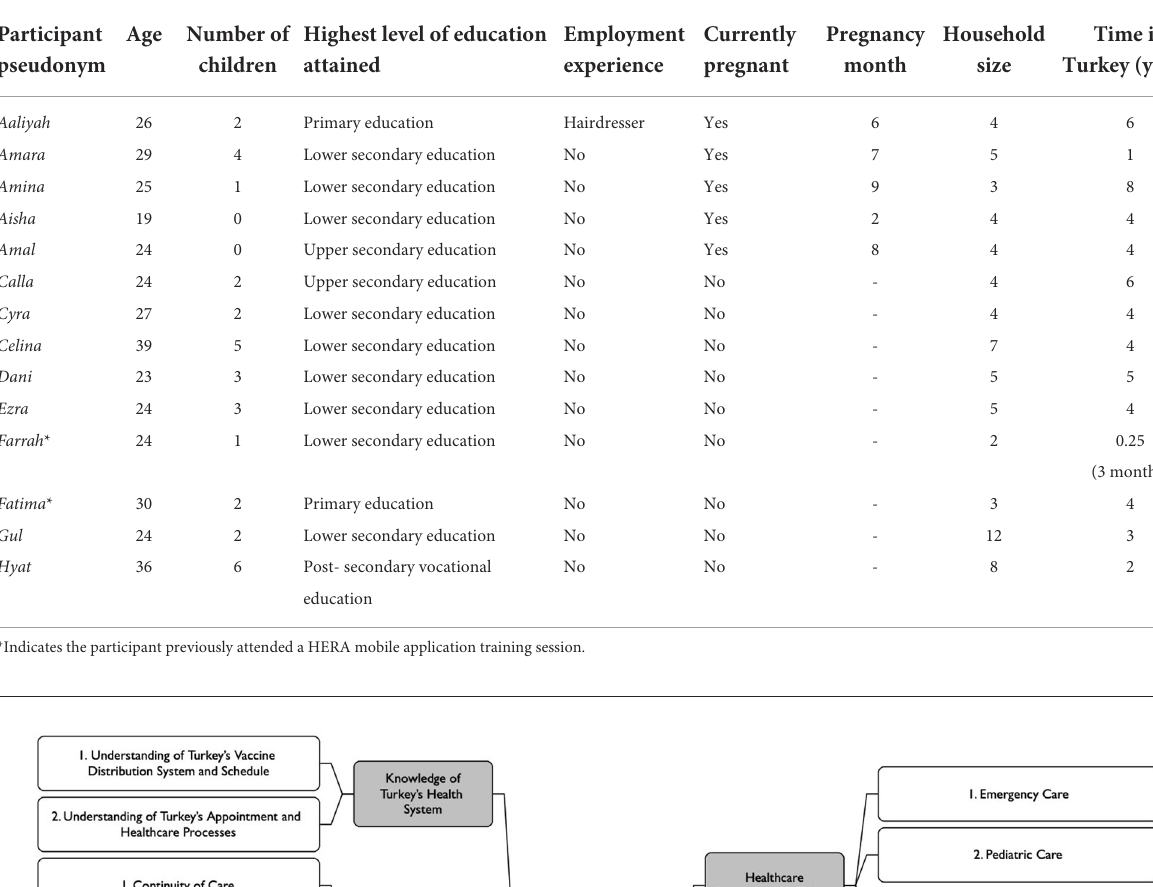
TABLE 1 Demographic characteristics of participants.